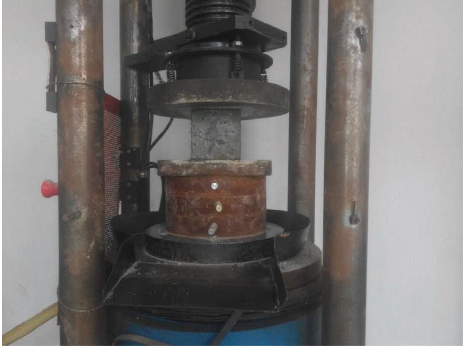
Figure 2: ARGFRC compression